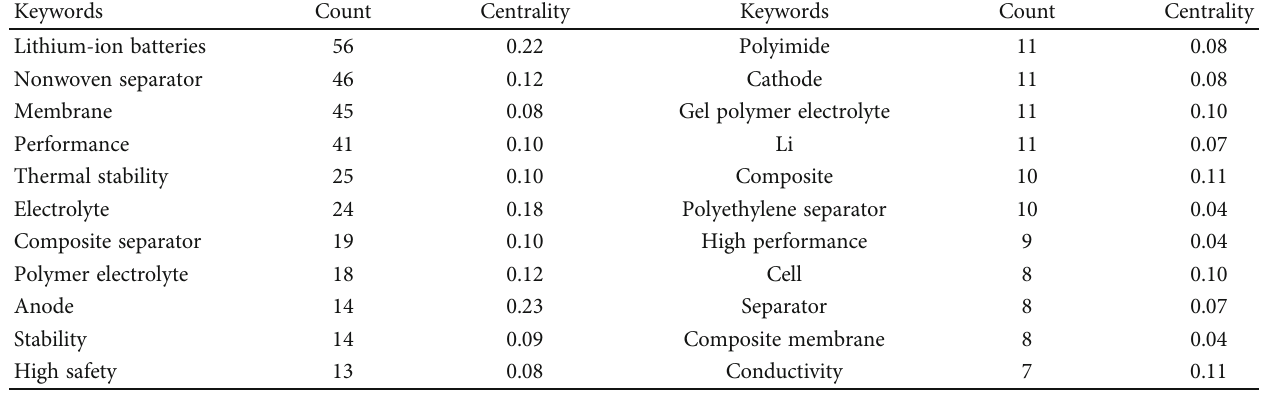
Table 4: Top 22 keyword frequency distribution of published